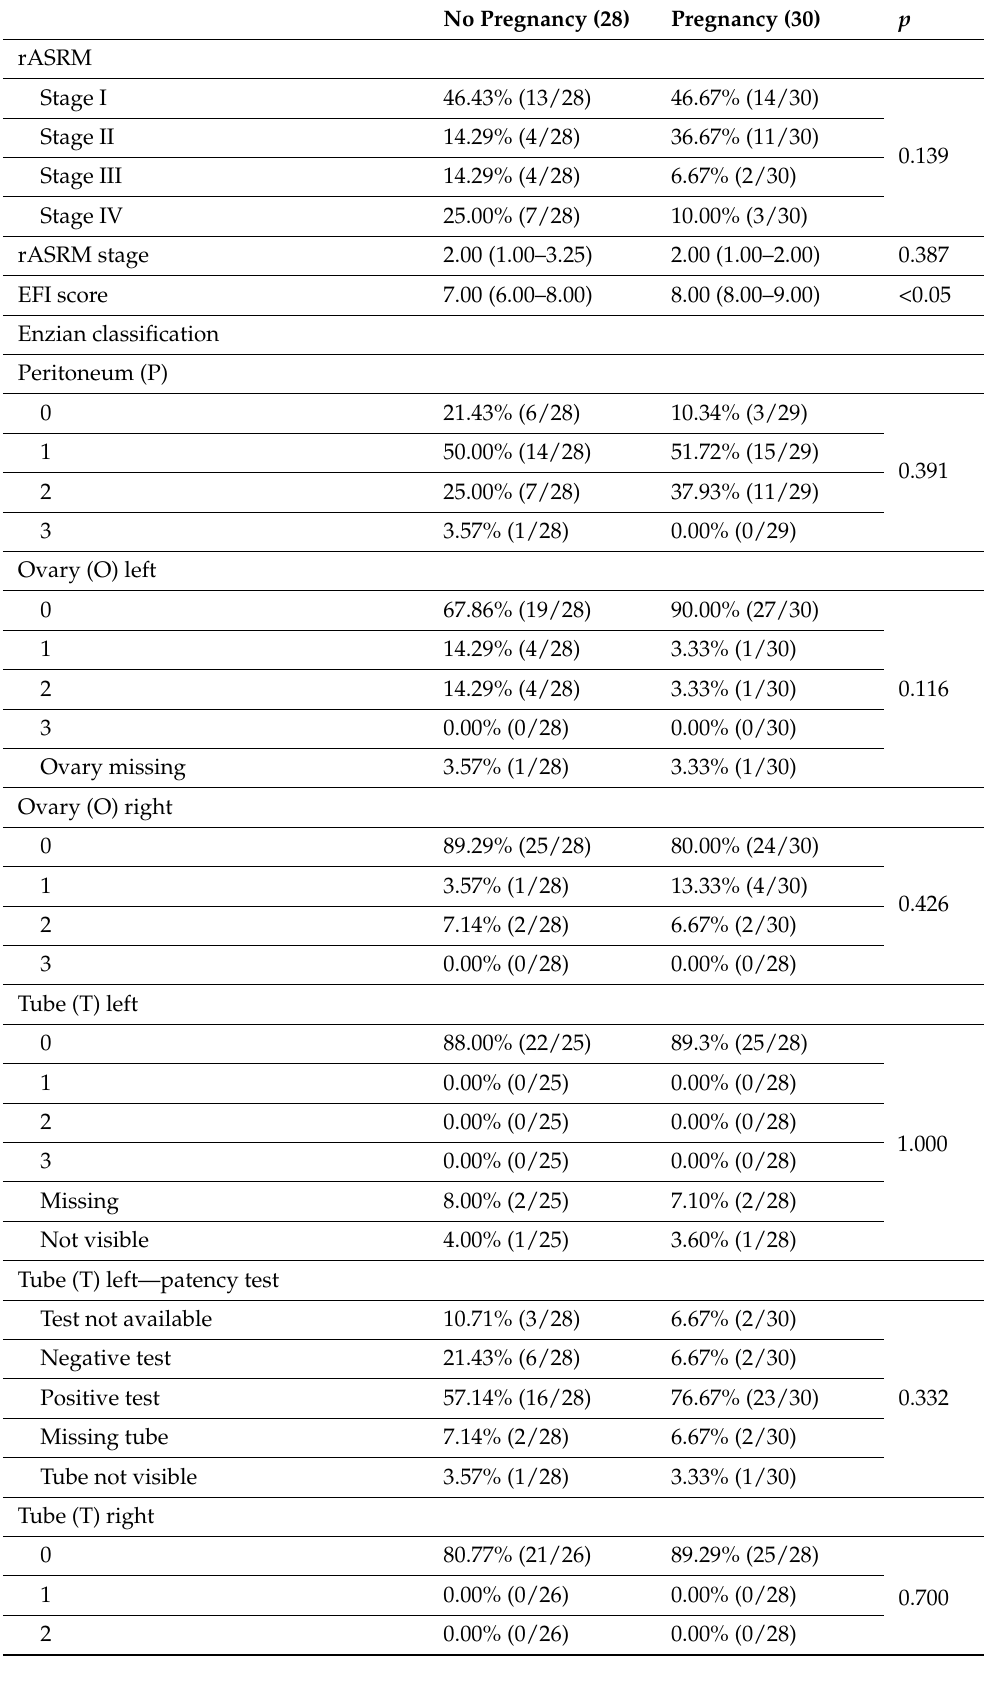
Table 1. All pregnancies: score subdivided in accordance with the pregnancy